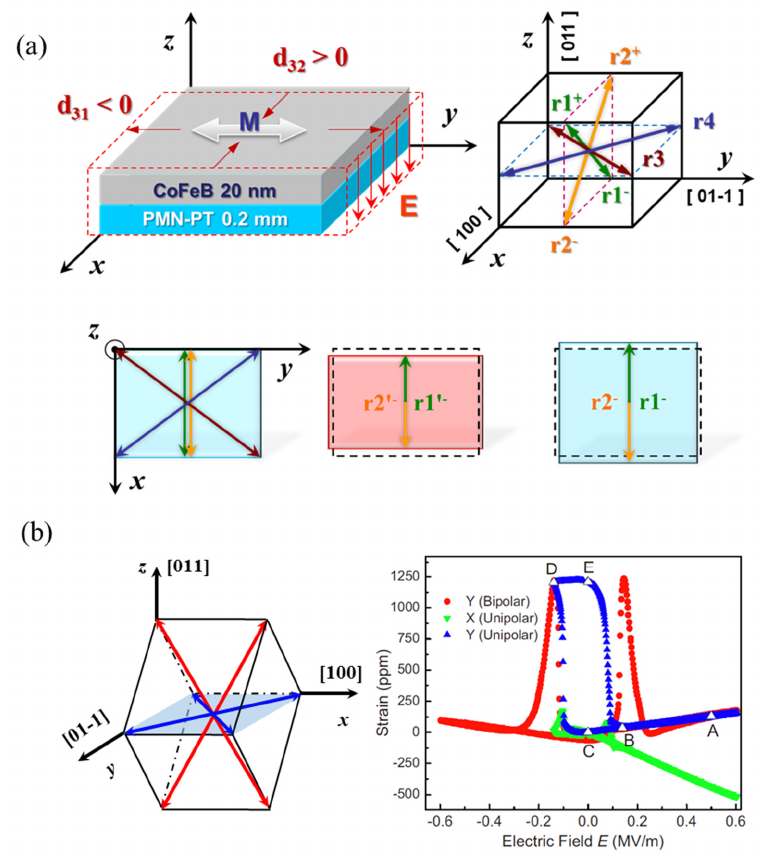
Figure 7. The anisotropic in-plane piezostrain and domain switching in the (011)-cut PMN–PT single crystal. ( a ) Sketch of the crystal structure, polarization of the (011)-cut PMN-PT, and the corresponding in-plane deformation under electric fields. ( b ) The polarization directions configuration for (011)-cut PMN–PT and in-plane piezostrains along the y and x direction. Reproduced with permission from reference [76,79].